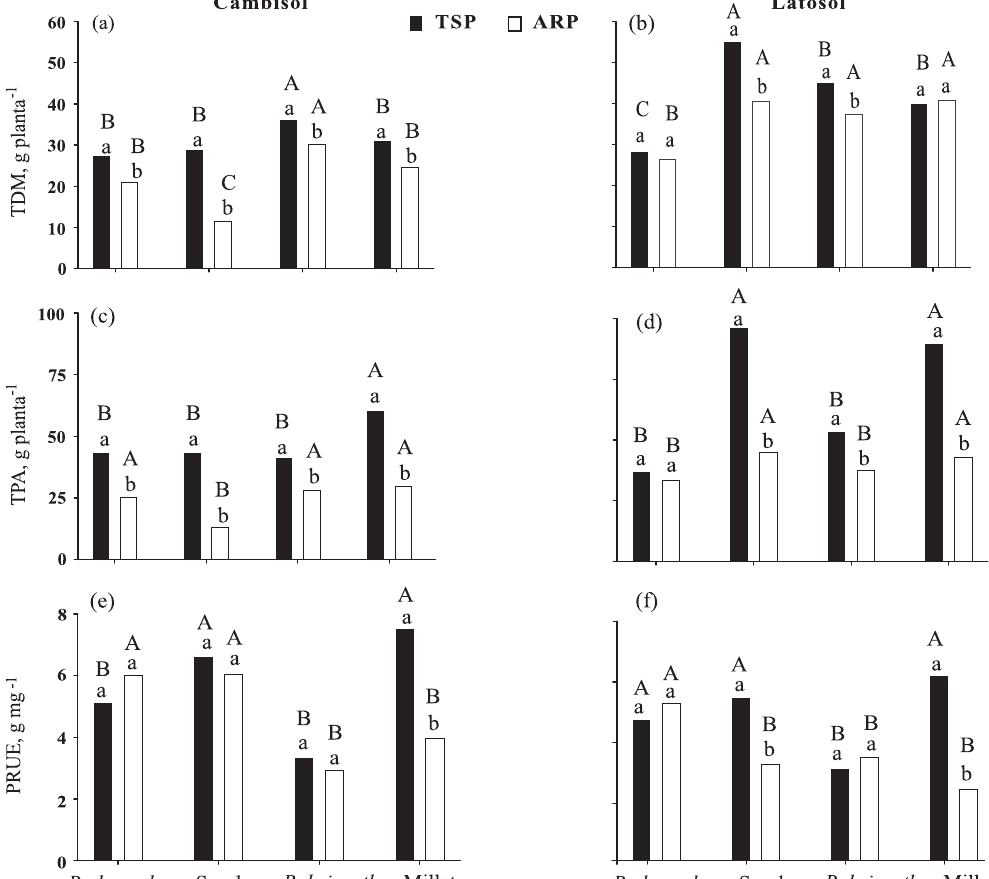
Figure 1. Total dry matter (TDM) (a and b), total P accumulation (TPA) (c and d) and P root uptake efficiency (PRUE) (e and f) of Brachiaria decumbens , sorghum, Brachiaria brizantha and millet, fertilized with triple superphosphate (TSP) and Arad reactive phosphate (ARP) on a Cambisol and a Latosol. Means did not differ from each other when followed by the same lower-case letter for both soils, in the comparison of P sources for each forage grass, and upper-case letters, in the comparison of forage grasses for each P source (Scott Knott 5